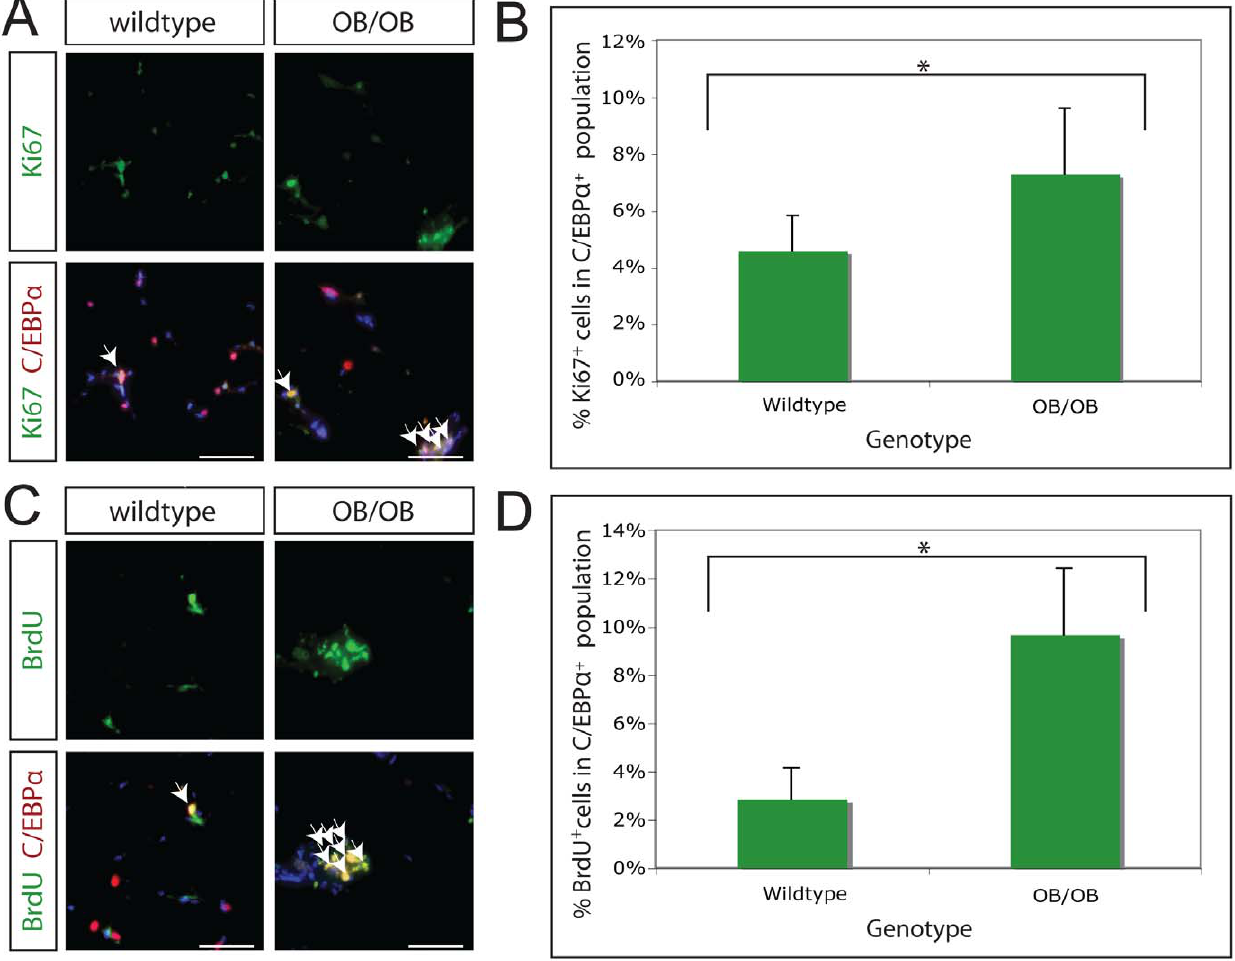
Figure 4. Increased adipose tissue replication in OB/OB mice. A. The rate of adipose tissue replication was assayed by co-staining for the cell cycle protein Ki67 (green) and the preadipocyte/adipocyte marker C/EBP a (red) in 14-week-old wildtype and OB/OB mice. Representative images of wildtype and OB/OB adipose tissue are shown. White arrows indicate cells co-staining for Ki67 and C/EBP a . DAPI stained nuclei are blue. Magnification, 200x; scale bars 100 m m. B. The percentage of C/EBP a -expressing cells in the growth cycle was quantitated for 14-week old C57/BL6 wildtype (n=9) and OB/OB (n=6) mice. There is a statistically significant increase in the rate of preadipocyte replication (p , 0.05) from 4.6% to 7.3%, in wildtype and OB/OB mice, respectively. C. The rate of adipose tissue replication was assayed by co-staining for BrdU incorporation (green) and the preadipocyte/adipocyte marker C/EBP a (red) in 14-week-old wildtype and OB/OB mice. Representative images of wildtype and OB/OB adipose tissue are shown. White arrows indicate cells co-staining for BrdU and C/EBP a . DAPI stained nuclei are blue. Magnification, 200x; scale bars 100 m m. D. The percentage of C/EBP a -expressing cells having incorporated BrdU following 5 days of BrdU injection was quantitated for 14-week old C57/BL6 wildtype (n=5) and OB/OB (n=6) mice. There is a statistically significant increase in the rate of adipose tissue replication (p , 0.05) from 2.9% to 9.7%, in wildtype and OB/OB mice, respectively.